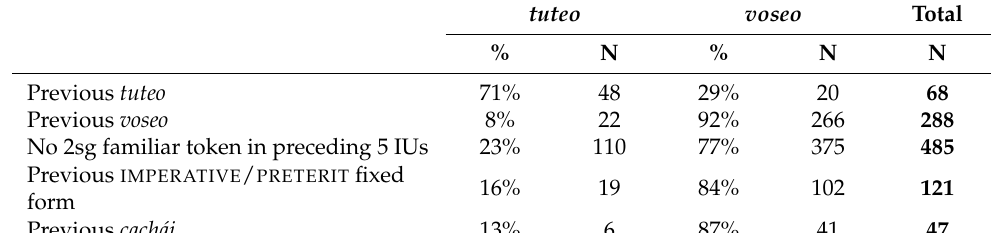
Table 3. Rates and relative frequency of tuteo vs. voseo by previous realization.